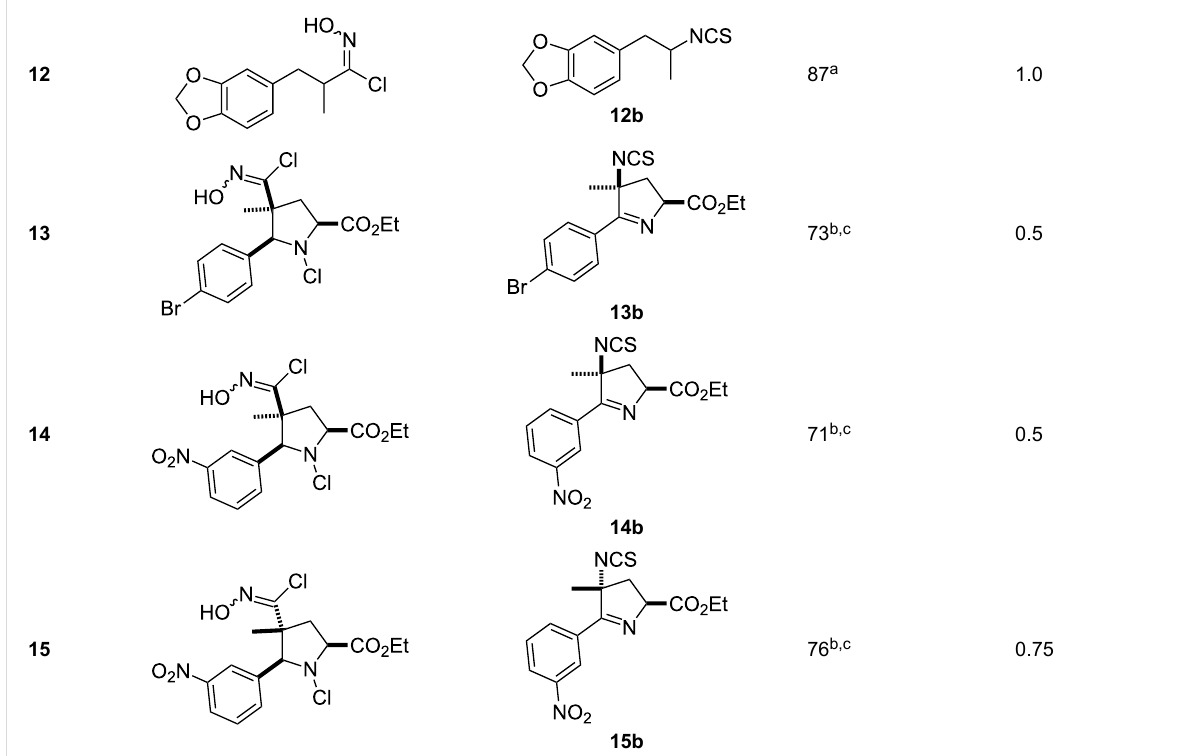
Table 2: Isothiocyanates prepared in flow.